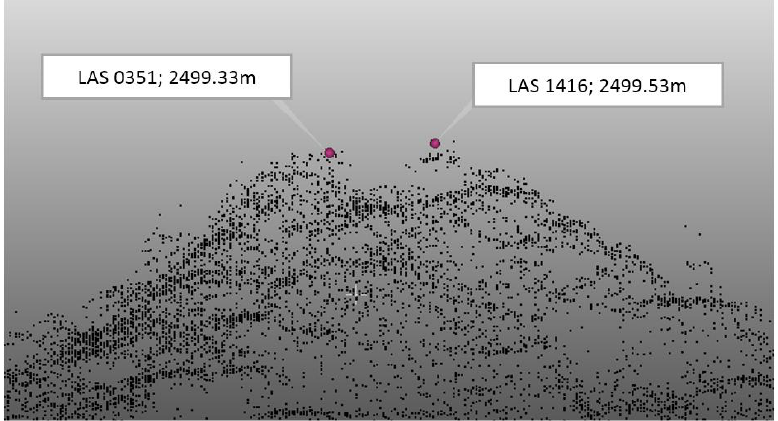
Figure 3. Rysy and the two highest Ground points detected in point clouds. Source: authors.